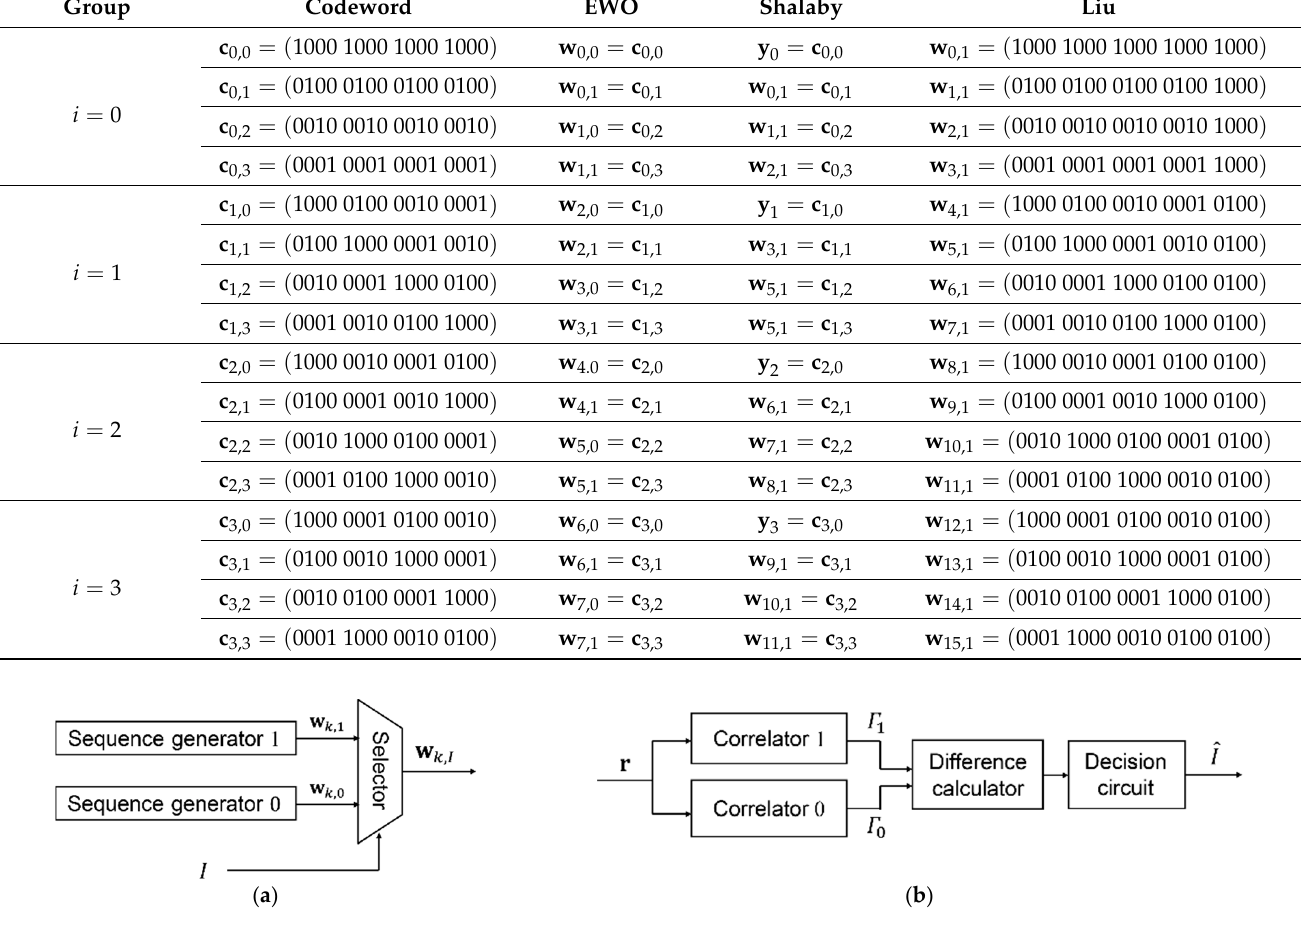
Figure 2. Block diagram of the 𝑘 th user’s encoder and decoder. ( a ) Block diagram of the encoder, ( b ) Block diagram of the decoder. Table 2. Codeword assignment for MPSC ( 𝑞 = 4 ).